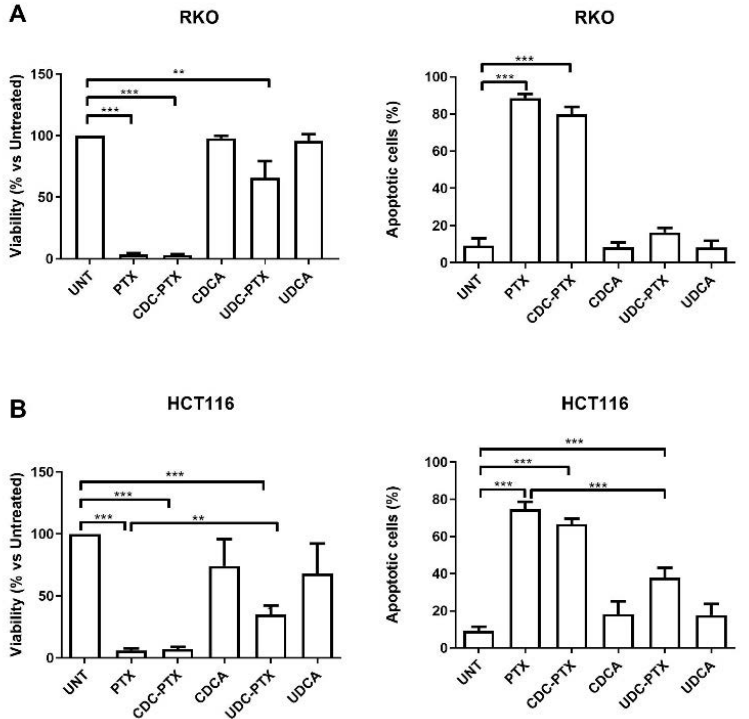
Figure 3. Viability and apoptotic cells evaluation in RKO ( A ) or HCT116 ( B ) cells after 4 h of treatment with 5 µ M of each compound (PTX; CDC-PTX, CDCA, UDC-PTX or UDCA) followed by 72 h of incubation with fresh media. Data are reported as mean ± SEM of at least 3 independent experiments. Statistical analysis was performed by ANOVA followed by Bonferroni post hoc test for pairwise comparisons. ** p < 0.01 or *** p < 0.001.